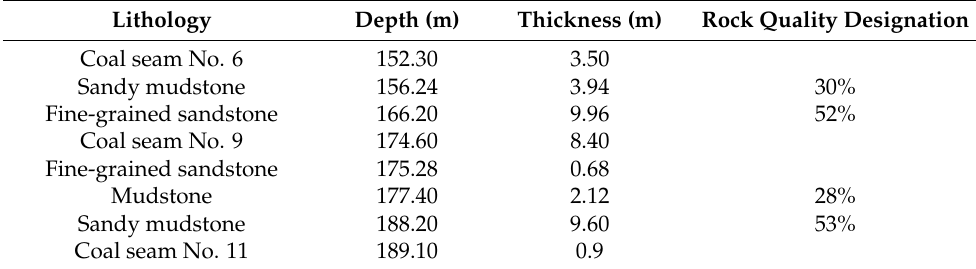
Table 1. YZK2101 drill hole.